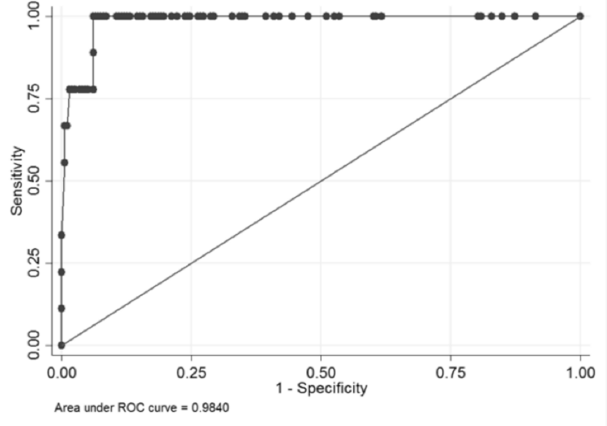
Figure 3. Area under the receiver operating characteristic (ROC) curve (AUC) of 98.4% .